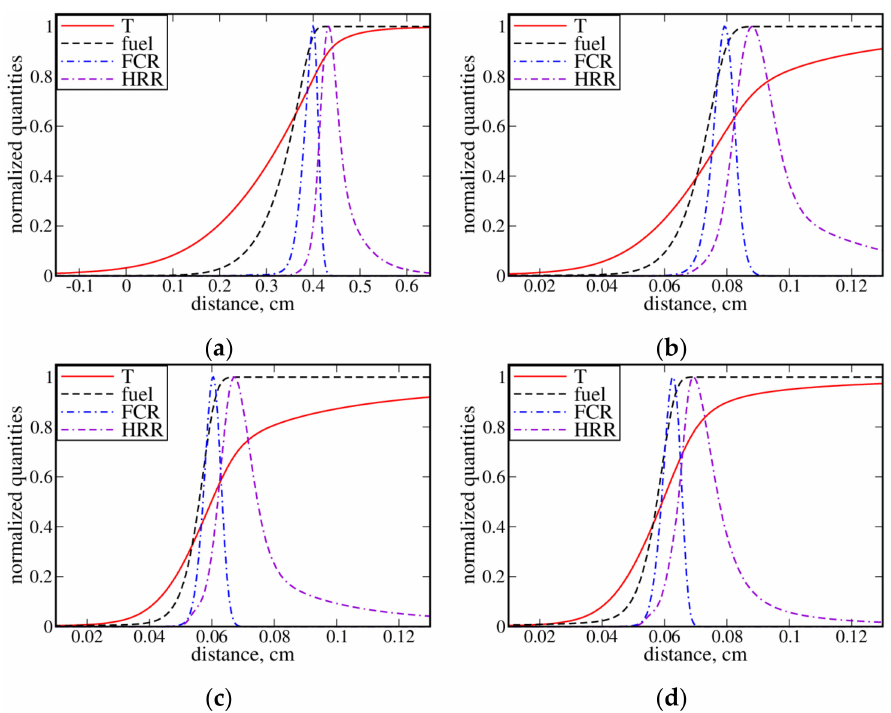
Figure 4. Profiles of c T , c F , fuel consumption rate, and heat release rate, normalized using their peak values. The profiles have been obtained from unperturbed n -heptane–air premixed flames characterized by different equivalence ratios: ( a ) φ = 0.4, ( b ) φ = 0.7, ( c ) φ = 1.0, and ( d ) φ = 1.3.